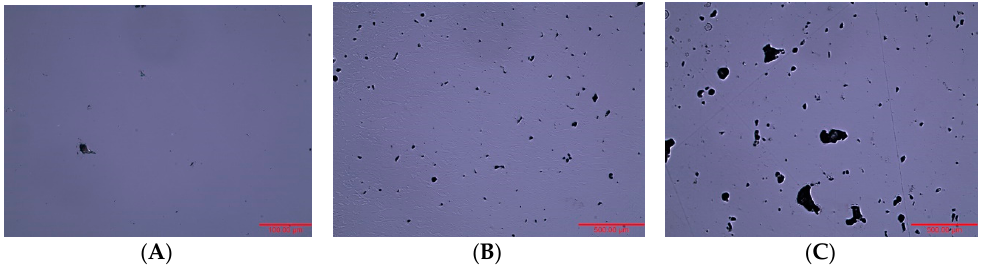
Figure 4. Porosity of cubes fabricated using parameters ( A ) (200 W); ( B ) (175 W); ( C ) (150 W).